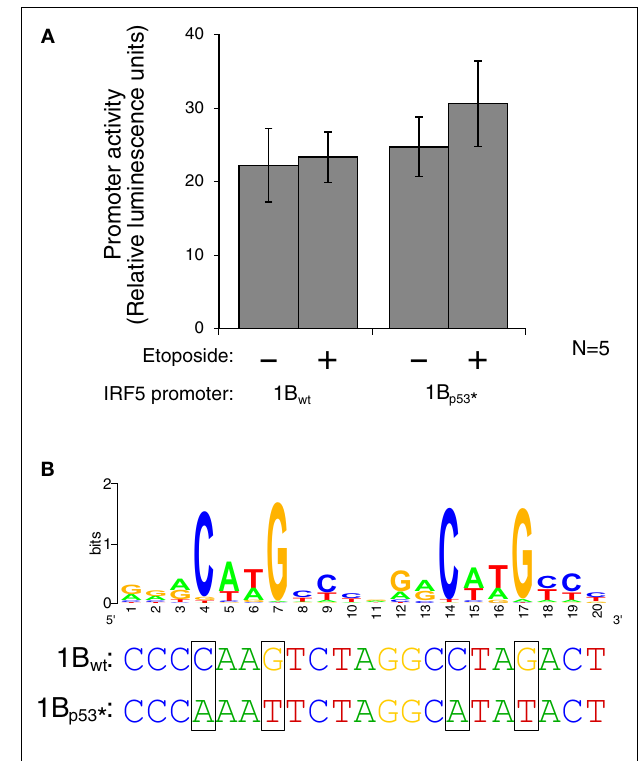
FIGURE 6 |The 2004640 risk allele affects responsiveness toTLR7 stimulation . (A) LCLs with either risk or protective genotypes were treated with imiquimod to stimulateTLR7. Expression of interferon-response genes before and after stimulation was compared using SYBR Green real-time PCR. RNA input was normalized for each sample using the housekeeping gene GAPDH. Increase after imiquimod stimulation for risk and protective cells is shown. IRF5 expression is higher after imiquimod stimulation in the risk cells, by 1.67-fold ( p = 0.021). Although Calreticulin expression decreases in both the risk and protective cells, it does so less in the risk cells ( p -0.05). CCR7 increases less in the risk cells after imiquimod treatment ( p = 0.05) N = 12 (B) . EBV status does not dramatically effect IRF5 levels. IRF5 expression was compared between LCLs and Ramos cells, a Burkitt’s lymphoma-derived B cell line that is EBV negative. IRF5 levels were not dramatically different between cell lines N = 2.